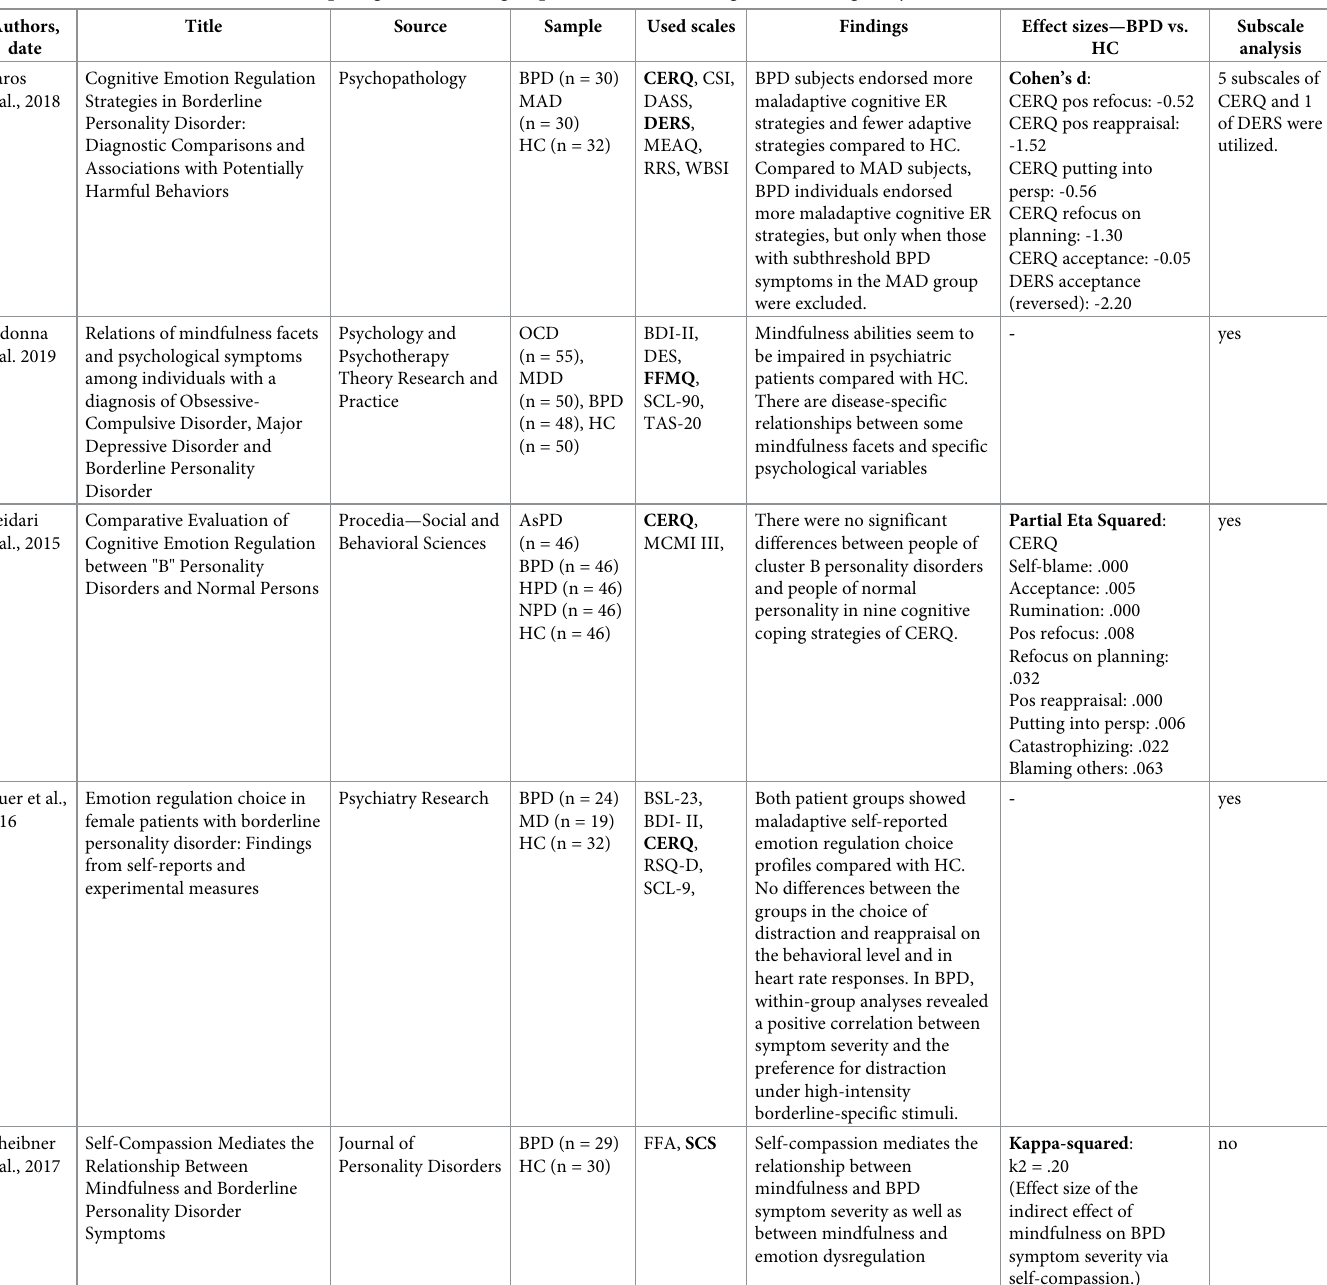
Table 1. Mini review of the literature comparing BPD and HC groups based on emotion regulation